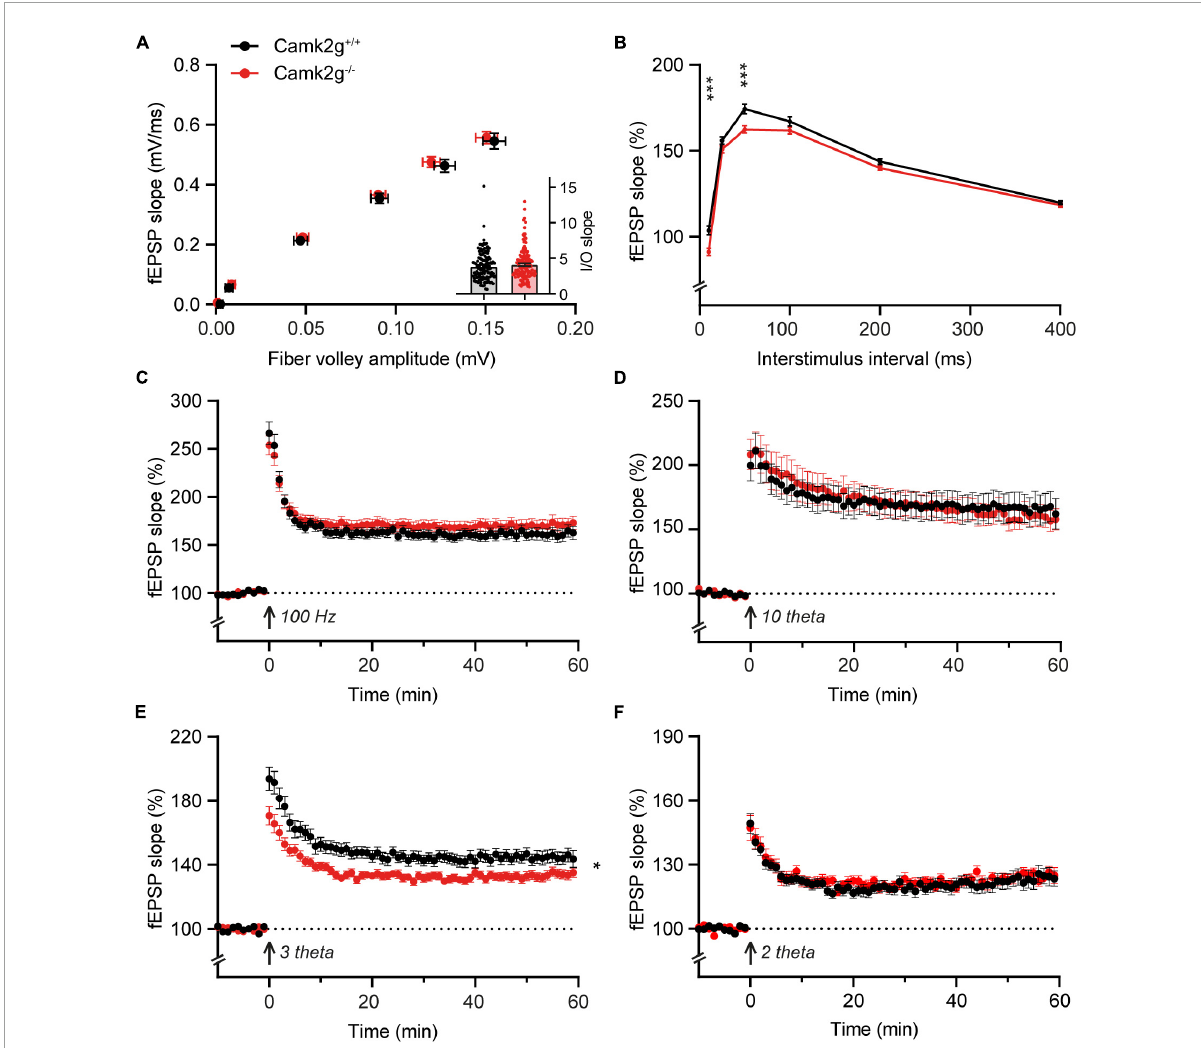
FIGURE3 CAMK2G in synaptic plasticity. (A) Field recordings were done in the Schaffer-collateral-CA1 synapses of the hippocampus. At baseline synaptic transmission, mice did not show differences in the input/output (I/O) between the presynaptic fiber volley and postsynaptic fEPSP with increasing stimulus strength [unpaired t -test on slopes of curve (inset), t ( 268 ) = 1.01, p = 0.314. Fiber volley n = 126/21 slices/mice for Camk2g + / + and n = 144/24 for Camk2g − / − ; fEPSP n = 144/21 for Camk2g + / + and n = 162/24 for Camk2g − / − ]. (B) We tested presynaptic short-term plasticity with paired-pulse facilitation and showed differences between Camk2g + / + and Camk2g - / − mice at interstimulus intervals of 10 and 50 ms [unpaired t -tests, 10 ms: t ( 197 ) = 3.70, p < 0.001; 25 ms: t ( 197 ) = 1.65, p = 0.101; 50 ms: t ( 197 ) = 3.45, p < 0.001; 100 ms: t ( 197 ) = 1.54, p = 0.125; 200 ms: t ( 197 ) = 1.82, p = 0.071; 400 ms: t ( 197 ) = 0.94, p = 0.352; n = 95/15 for Camk2g + / + and n = 104/17 for Camk2g − / − ]. (C) No differences were found in LTP elicited by stimulation at 100-Hz for 1 s [two-way repeated measures ANOVA on final 10 min, genotype: F ( 1 , 77 ) = 1.01, p = 0.318; n = 37/7 for Camk2g + / + and n = 42/8 for Camk2g − / − ]. (D) No differences were found in LTP elicited by 10-theta stimulation [two-way repeated measures ANOVA on final 10 min, genotype: F ( 1 , 35 ) = 0.25, p = 0.622; n = 19/5 for Camk2g + / + and n = 18/5 for Camk2g − / − ]. (E) Camk2g − / − mice showed reduced post-tetanic potentiation and LTP elicited by 3-theta stimulation [two-way repeated measures ANOVA on final 10 min, genotype: F ( 1 , 80 ) = 7.02, p = 0.010; n = 41/11 for Camk2g + / + and n = 42/12 for Camk2g − / − ]. (F)